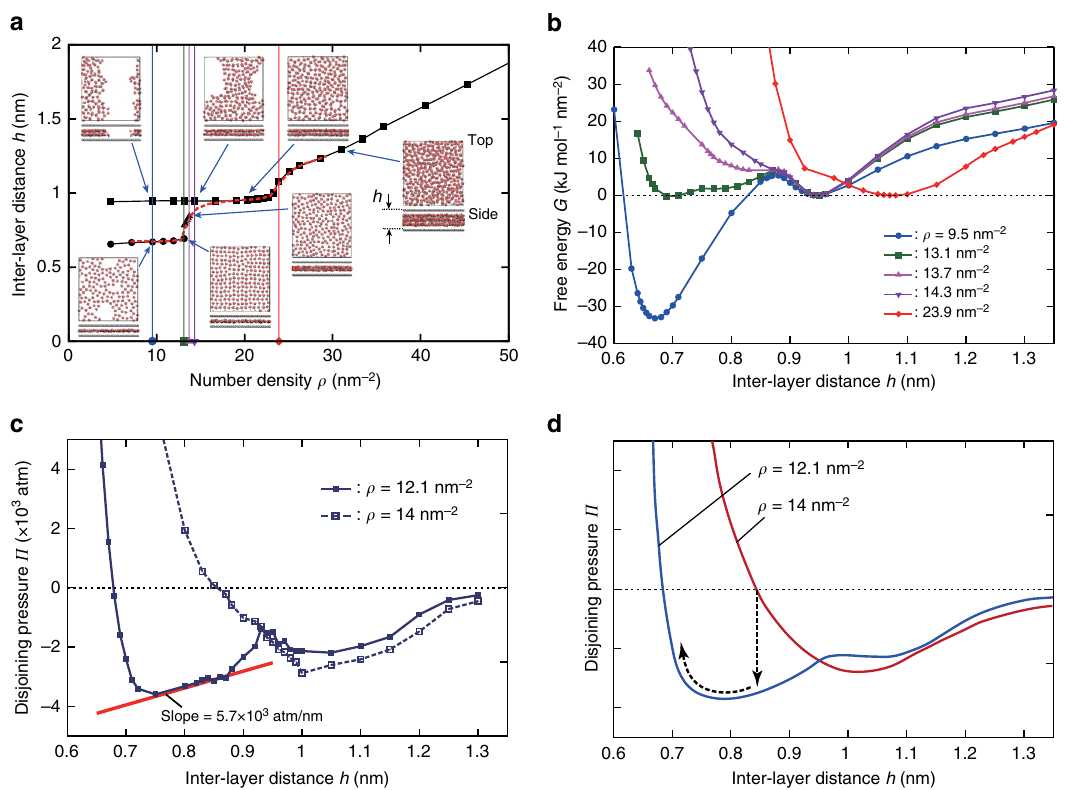
Fig. 2 Properties of water con fi ned between two rigid graphene sheets. a Interlayer distance h versus number density per unit area ρ , obtained for the system of water molecules between two rigid graphene sheets of size 3.9 × 4.3 nm 2 under a pressure of 1 atm. The top views of the water con fi guration and the side views of the water and rigid graphene sheets at several points are presented inside the graph. The red-dashed line shows the result obtained for the small size system (1.2 × 1.3 nm 2 .) b Free energy per unit area G at several values of ρ , along the vertical lines shown in a . The reference energy for each value of ρ is chosen such that G = 0 at the local minimum in h > 0.9 nm. c Disjoining pressure Π vs interlayer distance h for the small size system (1.2 × 1.3 nm 2 ), at ρ = 12.1 and 14 nm − 2 . The red line shows the slope of 5.7 × 10 3 atm nm − 1 used in the analysis of spinodal decomposition process as